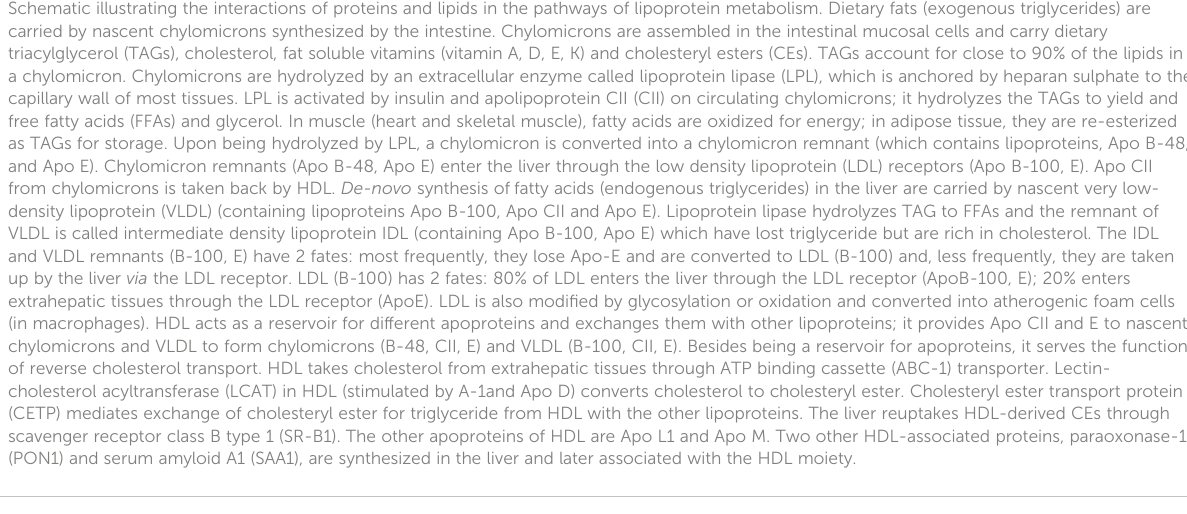
disease or an androgen-secreting tumor. All procedures were in accordance with the ethical standards of the Yorkshire and The Humber NRES ethical committee, UK, and the 1964 Helsinki